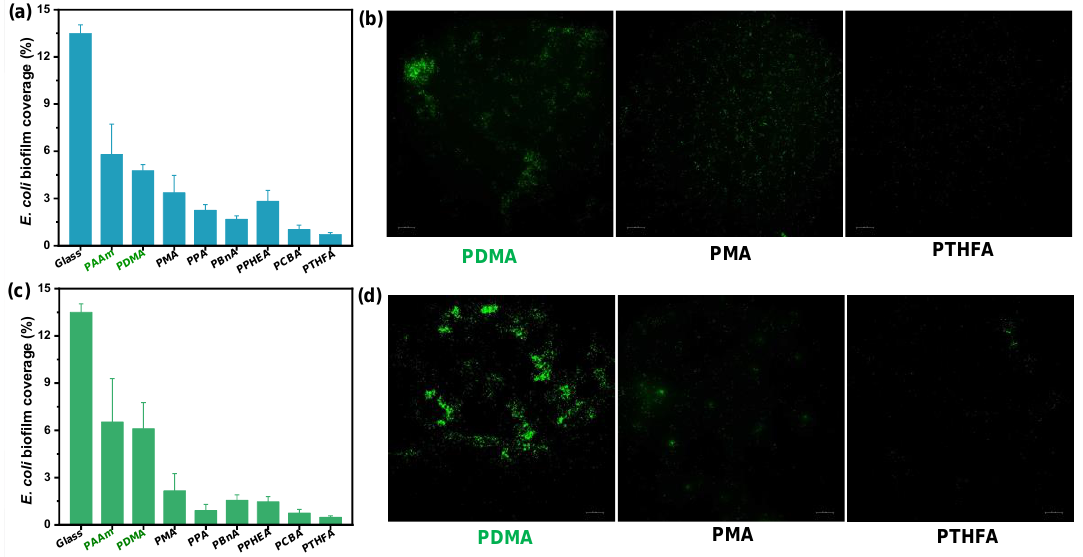
Figure 5. E. coli bacteria biofouling evaluation of typical hydrogels obtained by ( a , b ) the direct solvent exchange of as-prepared organo-gels after polymerization, and ( c , d ) the solvent exchange of organo-gels with equilibrium state in DMSO after incubation for 48 h in E. coli suspension. ( a , c ): Image analysis results (% biofilm coverage) of various surfaces: statistical analysis of the mean fluorescence intensity. ( b , d ): Typical fluorescence microscopy images of algae biofouling on hydrogels. In addition to the anti-bacterial adhesion, the hydrophobic hydrogels exhibited ex- cellent anti-fouling ability to the algae Spirulina platensis ( S. platensis ). Figure 7 shows the biofilm coverage and microscopy images of algae biofouling on the control and the